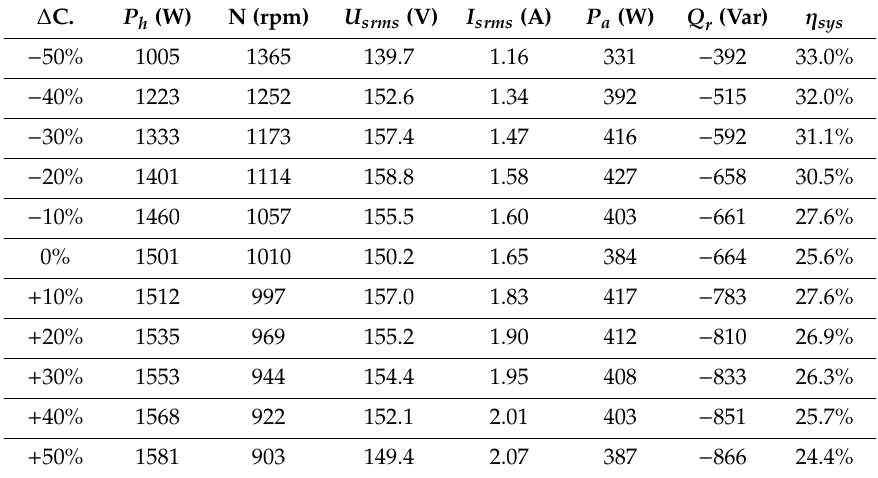
Table 7. Steady-state hydraulic and electromechanical quantities after a sudden change in the capacitors’